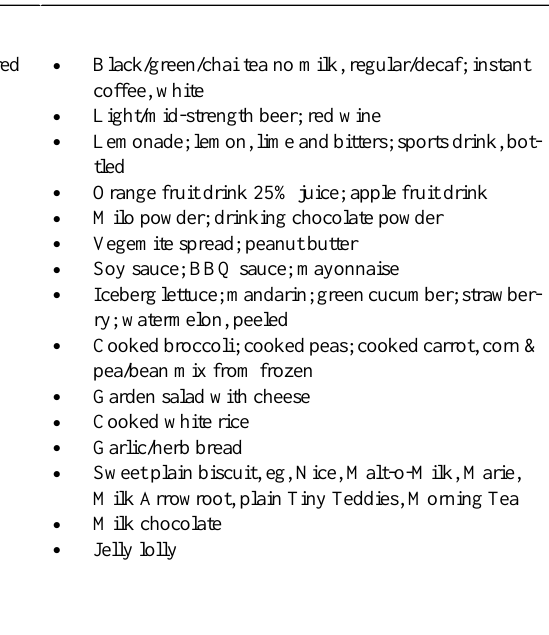
Food itemSuccess of participant and